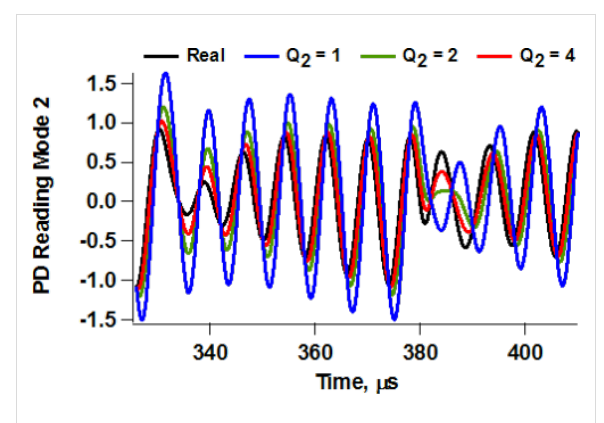
Figure 9: Illustration of the photodetector (PD) reading that would be obtained for a given second eigenmode trajectory (taken from a tip- excited bimodal simulation) for different values of the quality factor when the cantilever is driven using base excitation. There is a clear discrepancy between the photodetector reading and the real trajectory as Q